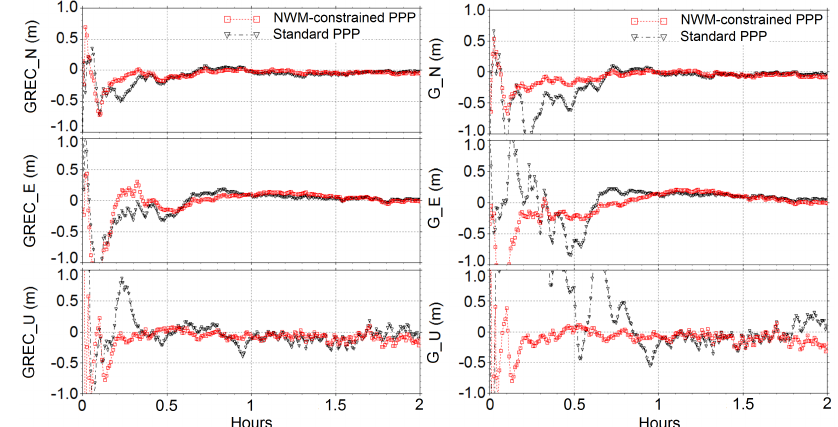
Figure 7. The multi-GNSS PPP (GREC) solution (left) and the stand-alone GPS PPP (G) solution (right) at station WIND (Windhoek, Namibia; 22.57 ◦ S, 17.09 ◦ E) on 12 September 2015 (DOY 255 of 2015). The standard PPP solutions are shown by black triangles, while the NWM-constrained PPP solutions are shown by red squares. Table 1. The summary over the solution improvements of the NWM-constrained PPP with respect to the standard PPP for both multi-GNSS and GPS solutions. Standard PPP NWM-constrained PPP